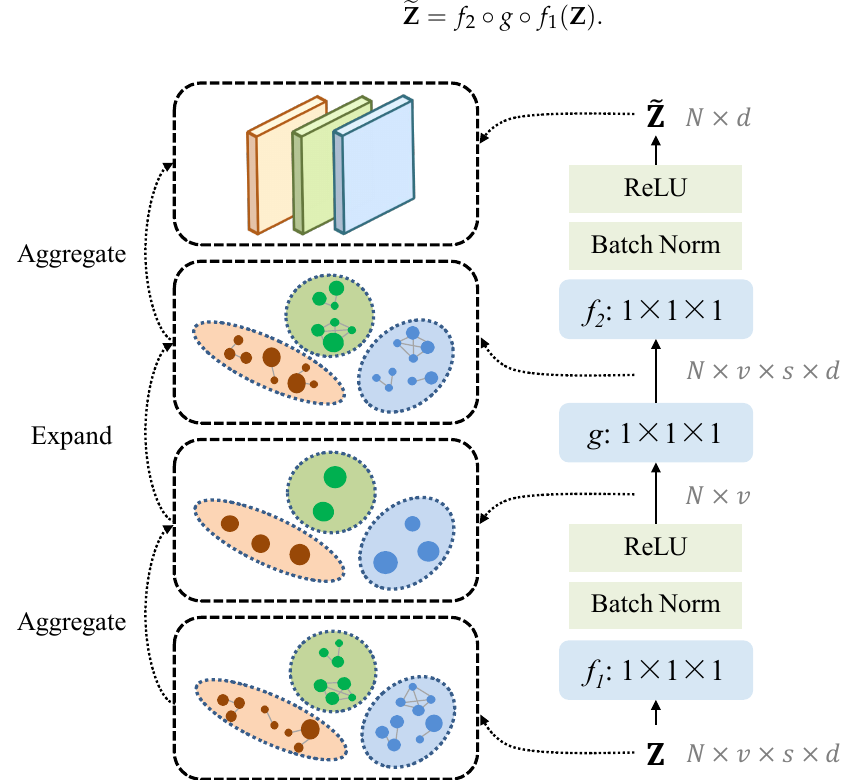
Figure 3. The detailed design of our proposed relational action bank